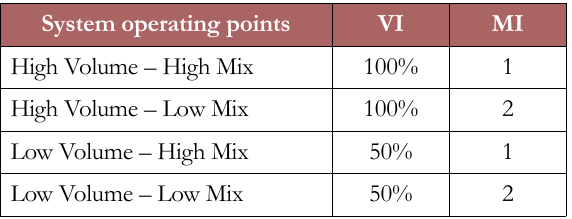
Table 6. Extreme conditions of flexibility